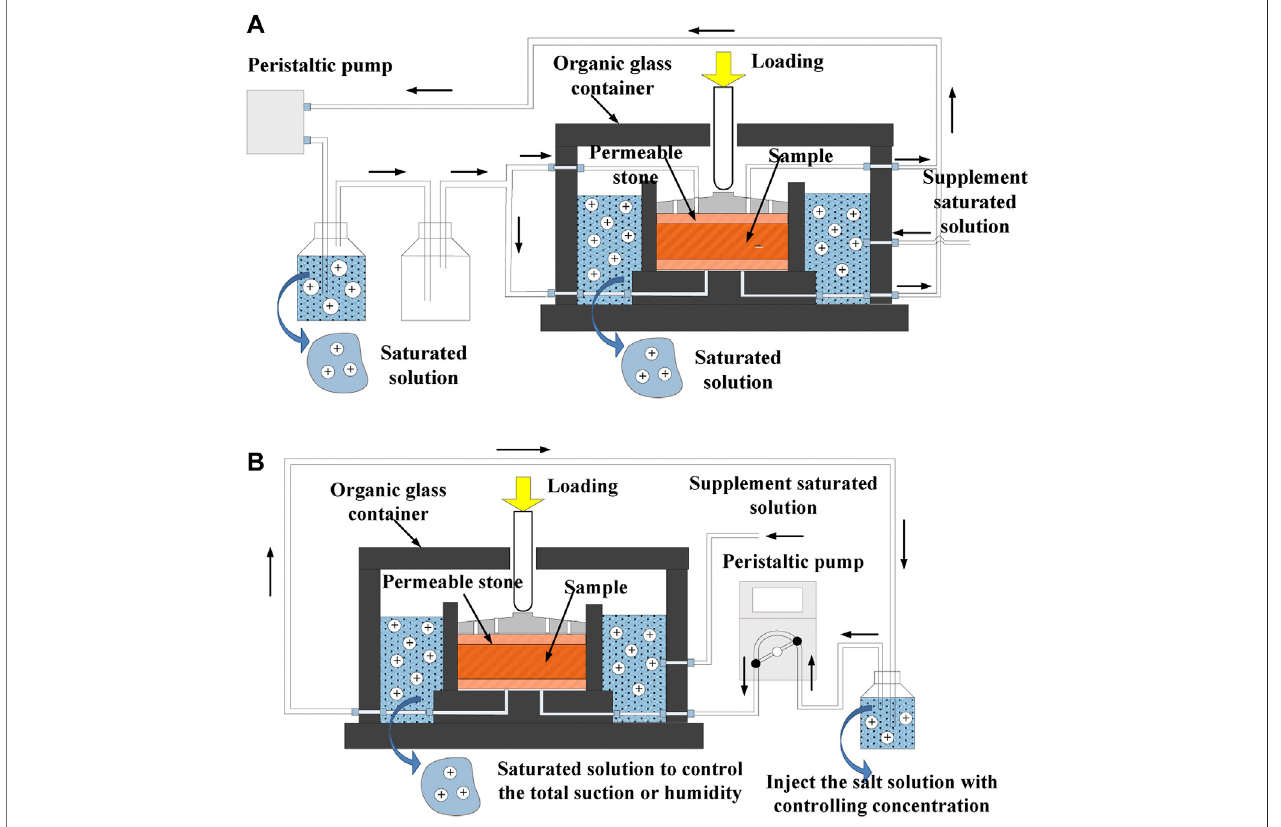
FIGURE 3 | The schematic diagram of modi fi ed oedometer tests with controlling total suction and injected solutions: (A) The set-up of total suction controlling device; (B) The set-up of solution injection device.